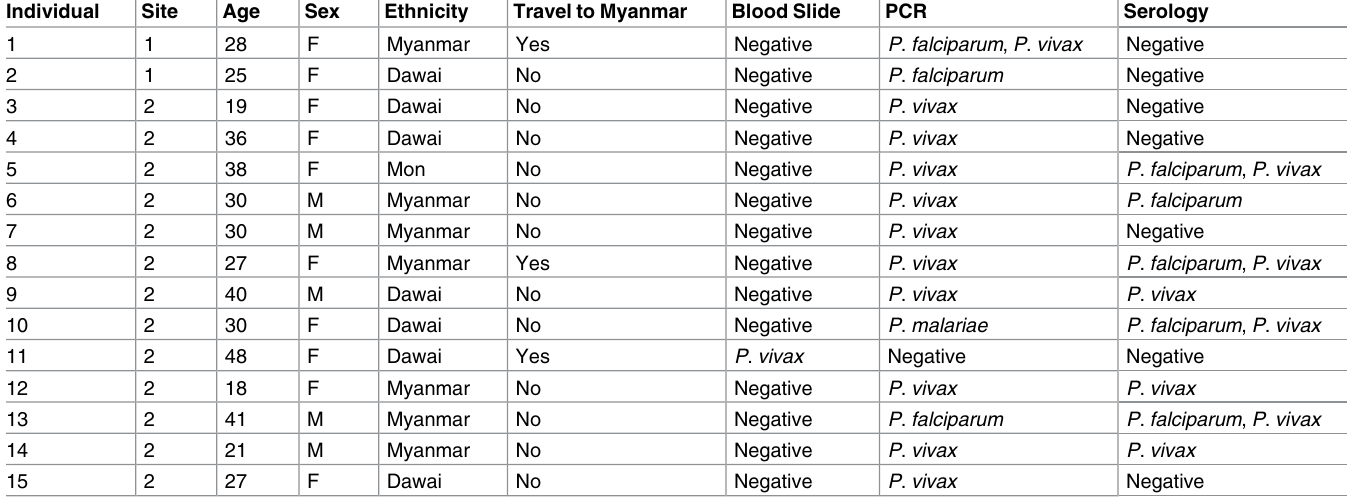
Table 5. Summaryof individuals with positive blood film, PCR, and/or